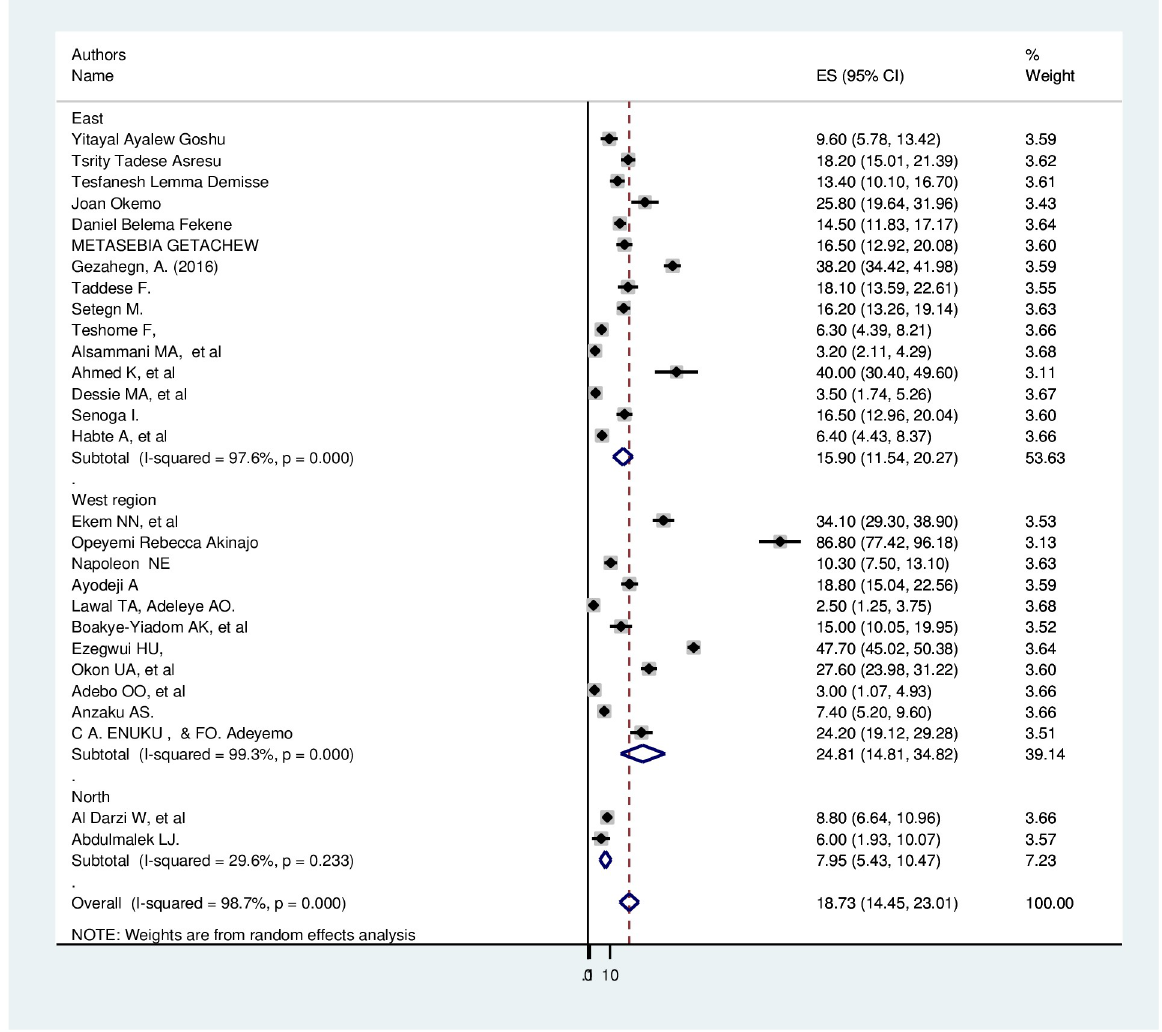
Fig 3. Subgroup analysis of utilization of preconception care among mother by country in Africa.